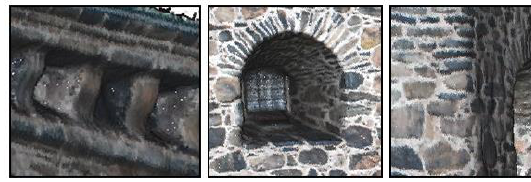
Figure 7 . Details of the sprase point cloud.